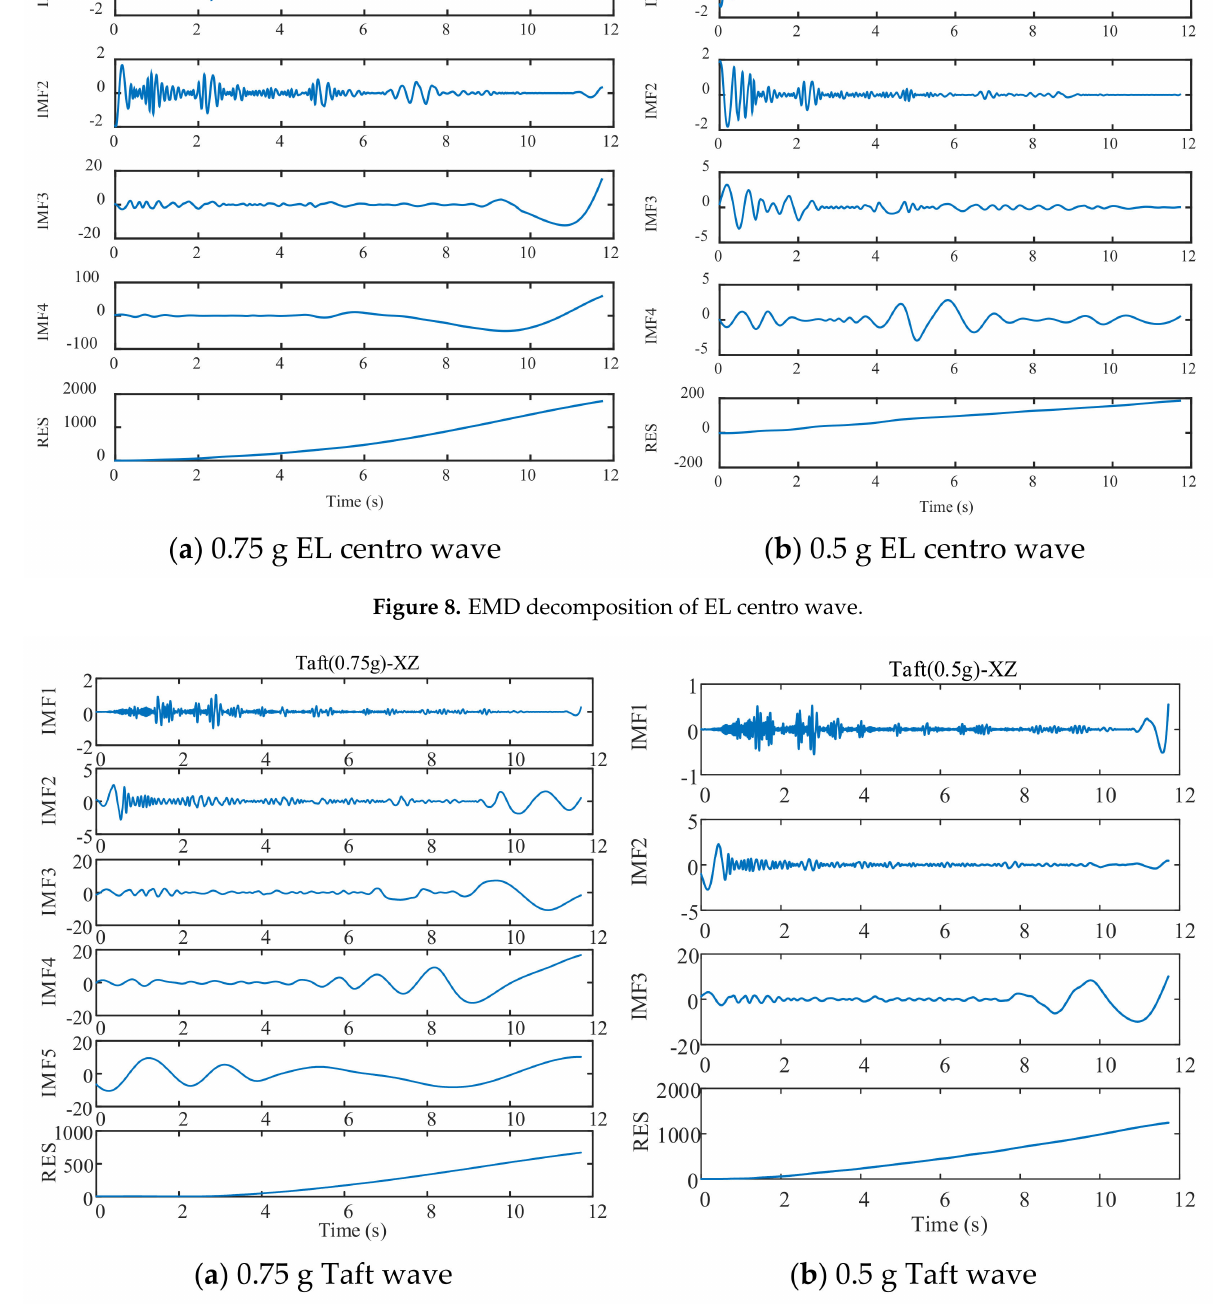
Figure 9. EMD decomposition of Taft